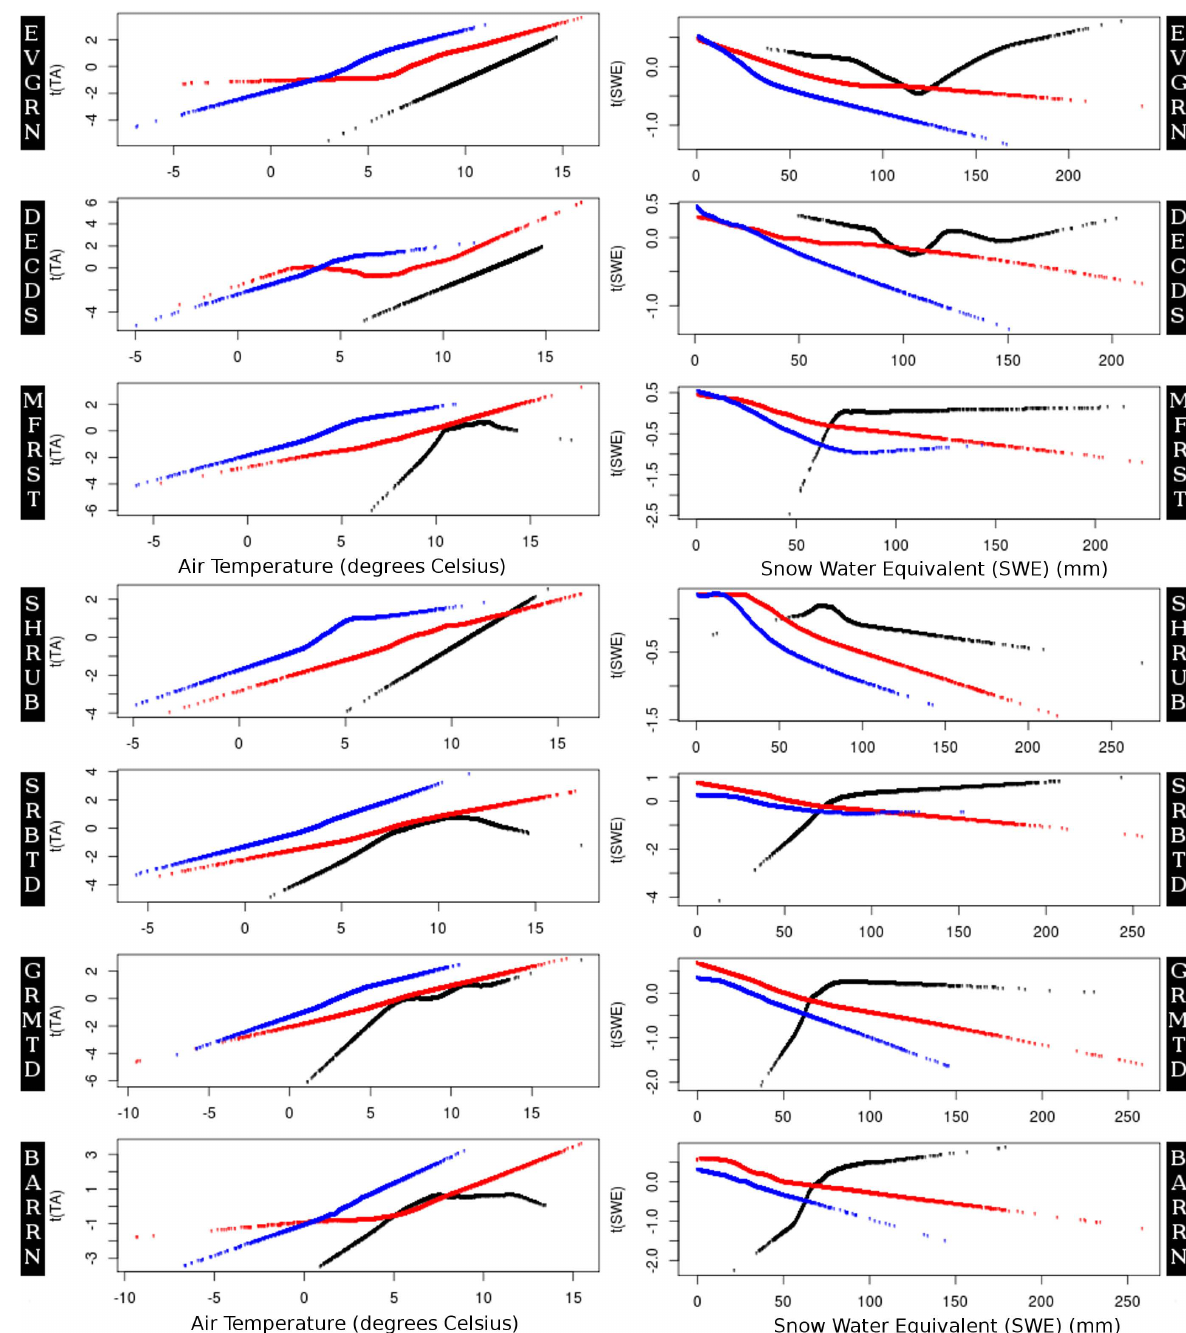
Fig. 4. a–c: Point pair output from the ACE algorithm indicating associations between air temperature (TA) and SWE ([TA, t (TA)] and [SWE, t (SWE)]) over three time periods: mean annual (black), 30 days preceding and 30 days following snowmelt (red), and 30 days preceding and 30 days following snow onset (blue). Results are indicated separately for all forested vegetation classes. d–g: Point pair output from the ACE algorithm indicating associations between air temperature (TA) and SWE ([TA, t (TA)] and [SWE, t (SWE)]) over three time periods: mean annual (black), 30 days preceding and 30 days following snowmelt (red), and 30 days preceding and 30 days following snow onset (blue). Results are indicated for separately for all non-forested vegetation